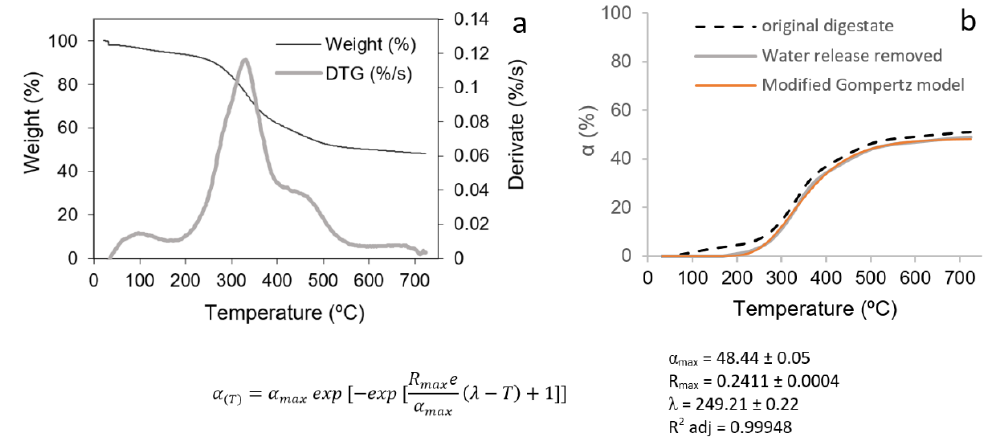
Figure 6. ( a ) TG and DTG profile of the digested sample after a six-month stabilization period at an ambient temperature. ( b ) Conversion profile derived from TG sample. Data were fitted using the modified Gompertz model after removing the effect of water release.